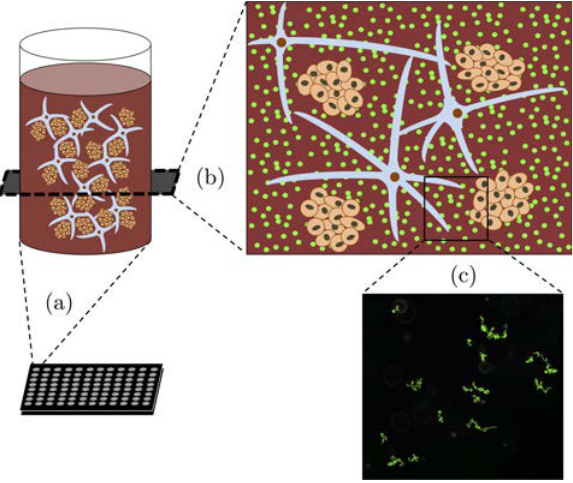
Fig. 1. Schematic representation of PTM applied to a 3D cancer model. (a) 3D cultures containing embedded °uorescent probes are prepared in a 96-well plate. (b) Each well is imaged under 40 (cid:1) magni¯cation at a uniform Z position. (c) Brownian motion of tracer probes is recorded under °uorescent excitation and video is processed in order to track probe trajectories and calculate MSD.